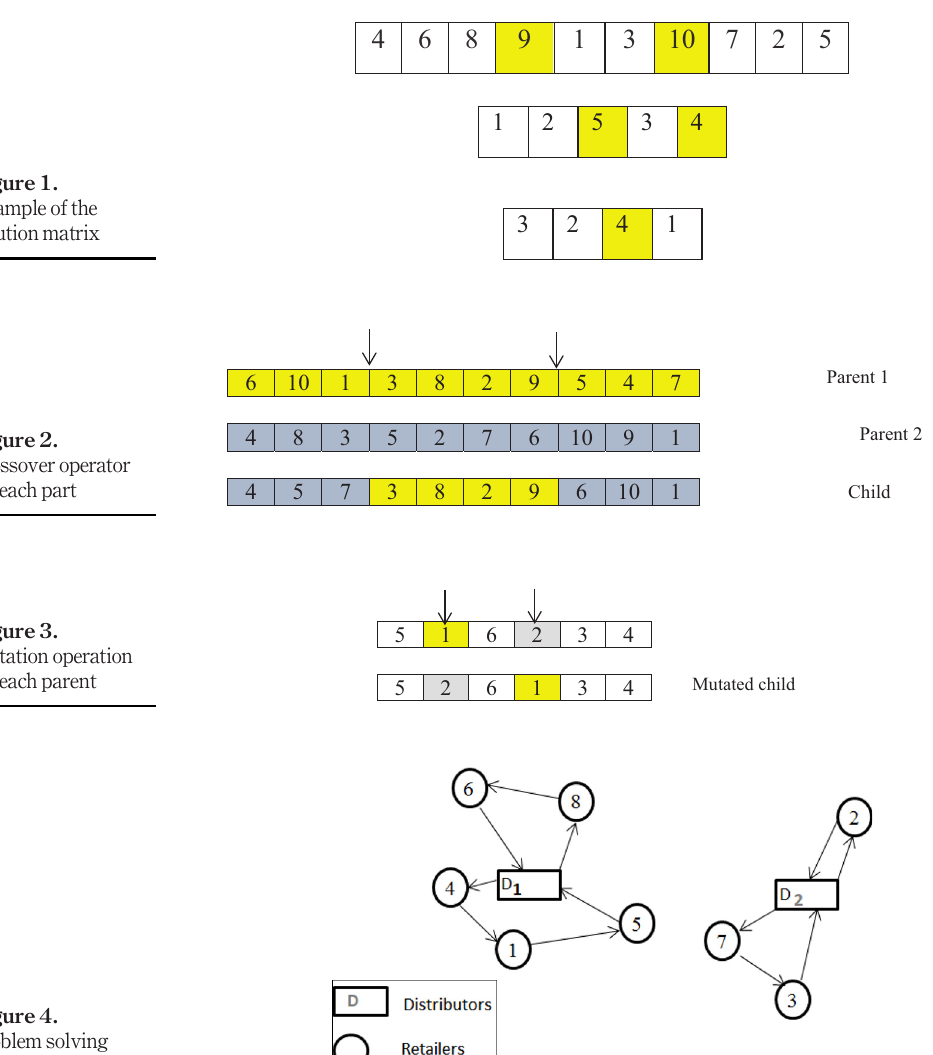
Figure 4. Problem solving